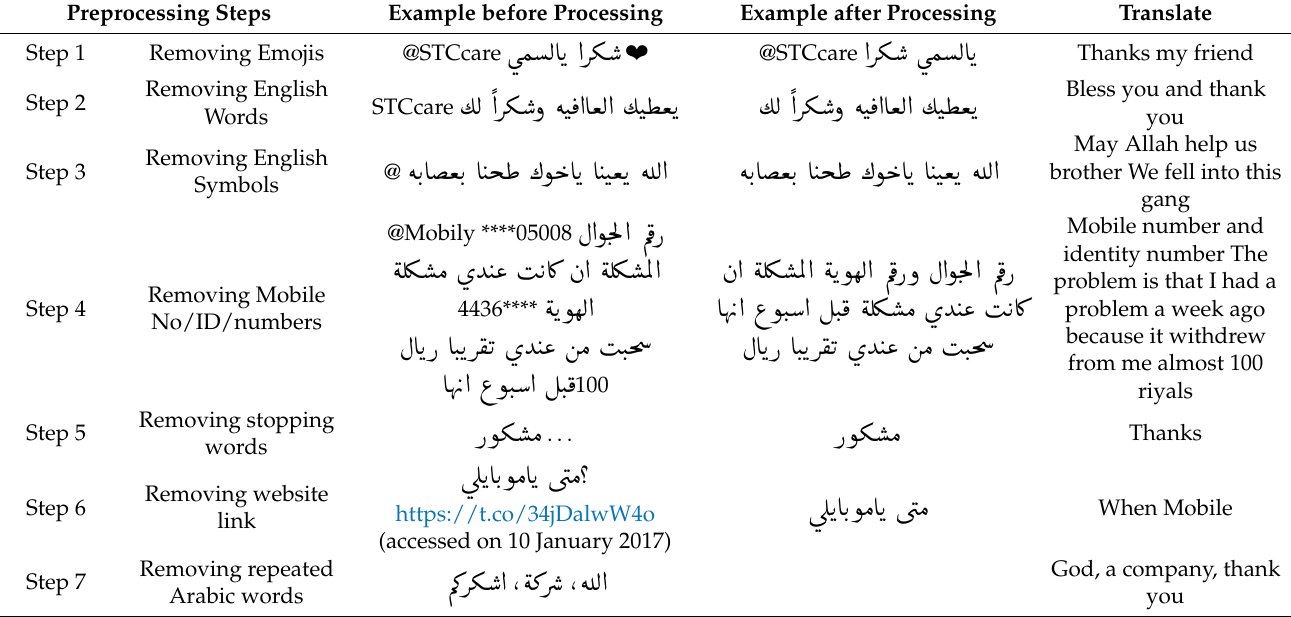
Table 1. Pre-processing steps of the datasets. Table 1. Pre ‐ processing steps of the